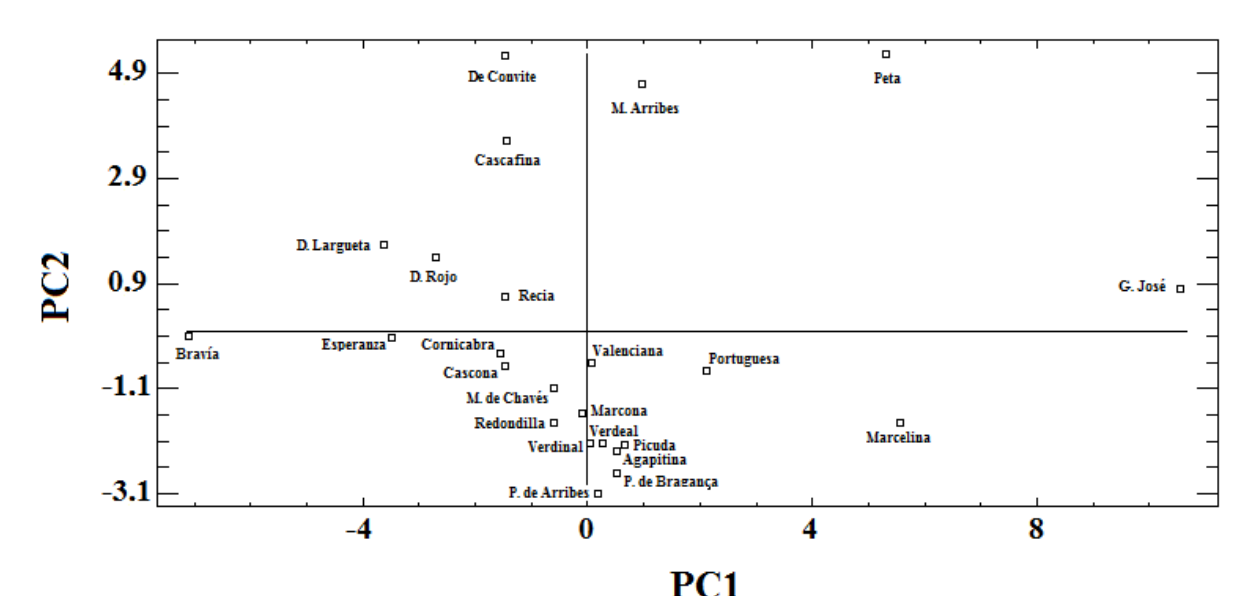
Figure 1. Scatterplot of the first two principal components (PCs) for the 24 traditional almond cultivars based on agromor- phological and chemical characteristics.